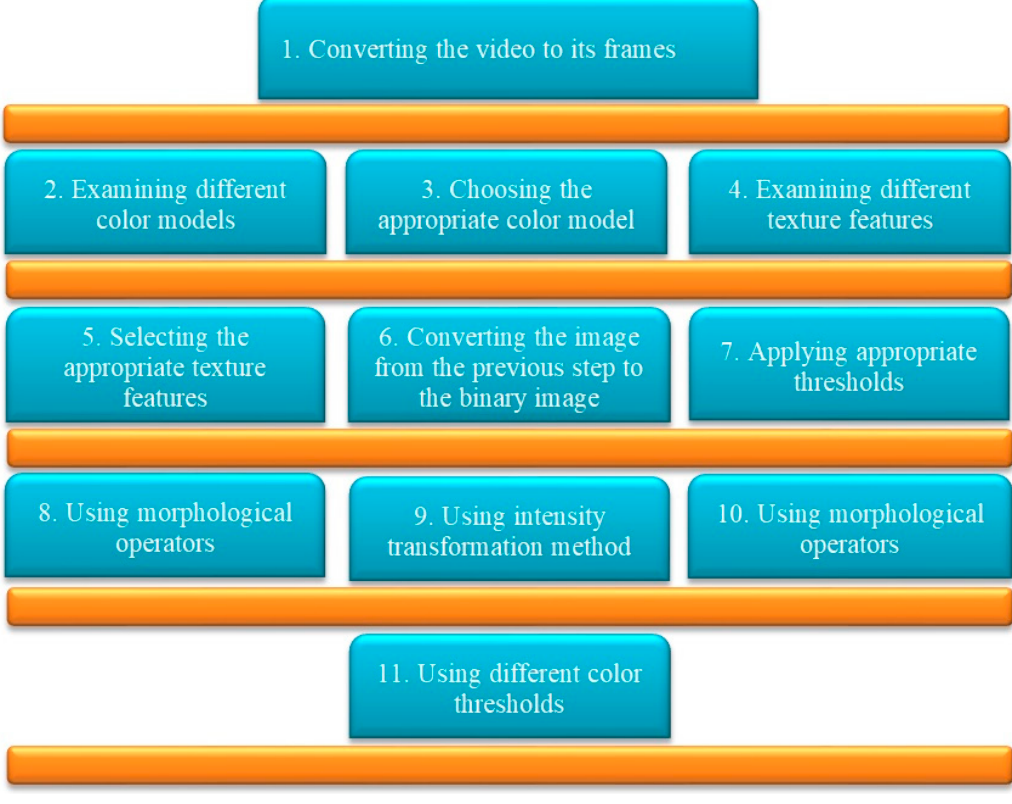
Figure 1. Di ff erent stages in the development of segmentation Figure 1. Different stages in the development of segmentation algorithm.